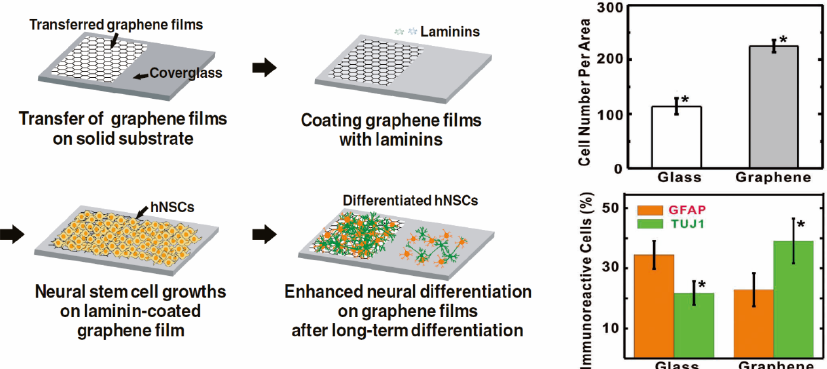
Figure 2. The enhancement of growth and differentiation of human neural stem cells (hNSCs) on graphene ‐ coated cover glass. β 3 Tubulin (Tuj1) and glial fibrillary acidic protein (GFAP) are the representative markers of neurons and glial cells, respectively. Reprinted with permission from [45[. Copyright 2011 John Wiley and Sons.